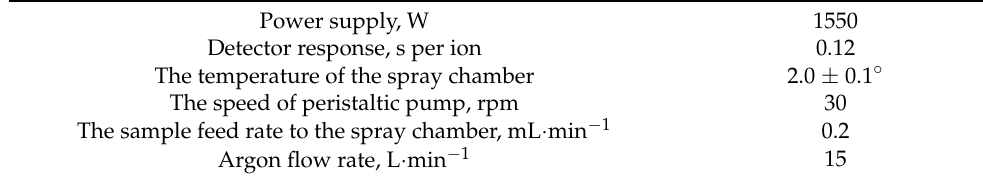
Table 1. Working parameters of ICP-MS-spectrometer.